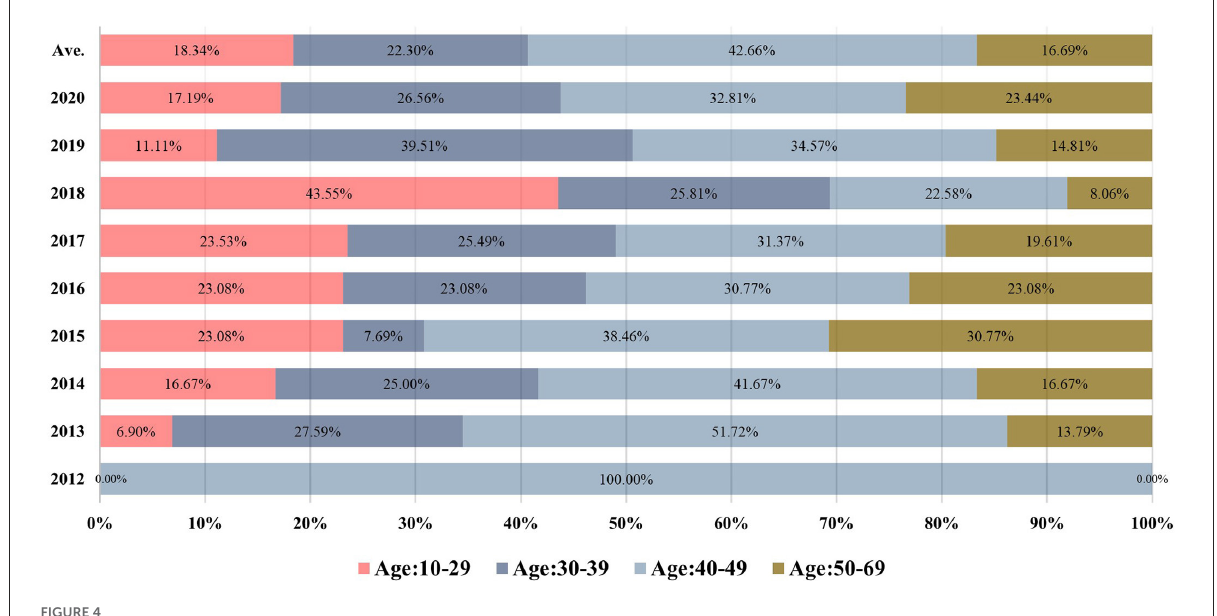
FIGURE4 Age distribution of WCO defendants from 2012 to 2020 ( N = 338).